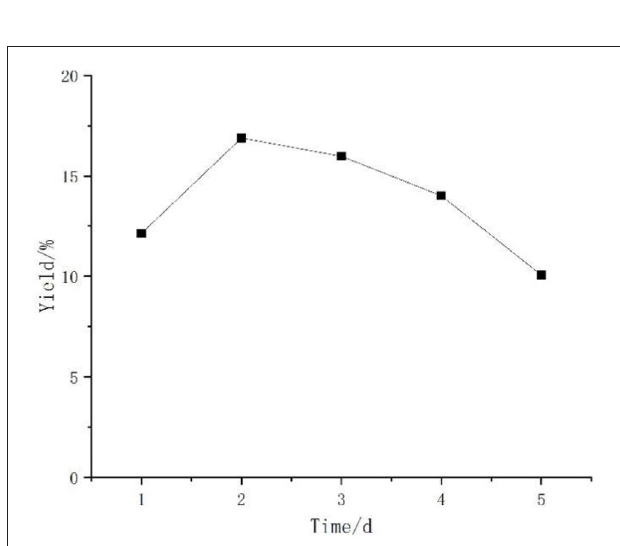
FIGURE 3 | Effect of time on the yield of Artemisia polysaccharides.